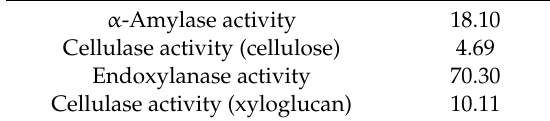
Table 1. Enzymatic activities (in ∆ OD / g*min*) of the enzymatic cocktail obtained from SSF of wheat bran by A. oryzae .